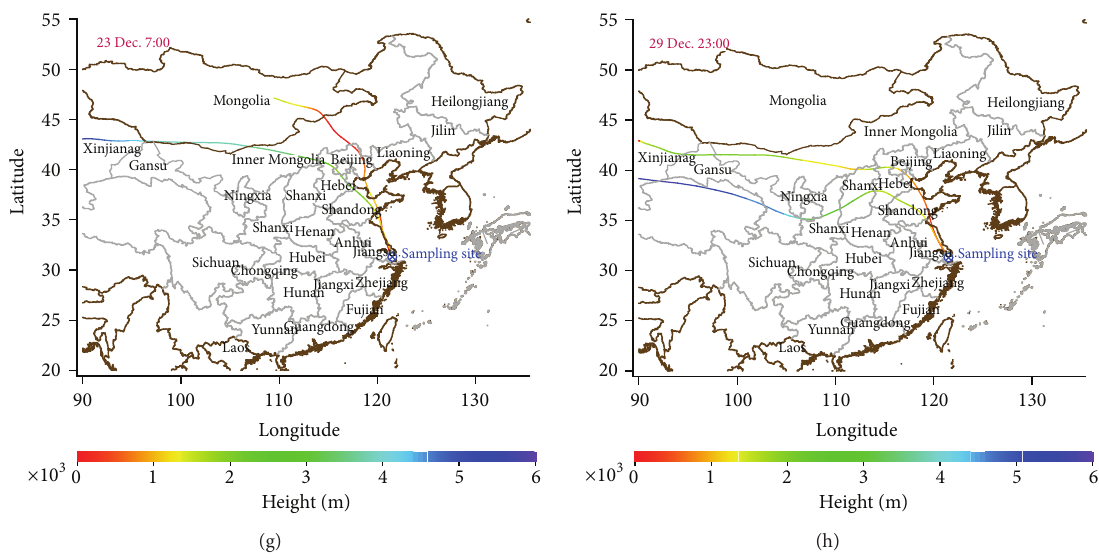
Figure 6: Air massbackward trajectories for 500- and 1000-meter altitude arriving in the measurement site at the very beginning of the haze periods (a) 3/12 at 12:00, (b) 7/12 at 22:00, (c) 14/12 at 12:00, (d) 16/12 at 15:00, (e) 21/12 at 09:00, (f) 22/12 at 09:00, (g) 23/12 at 07:00, and (h) 29/12 at